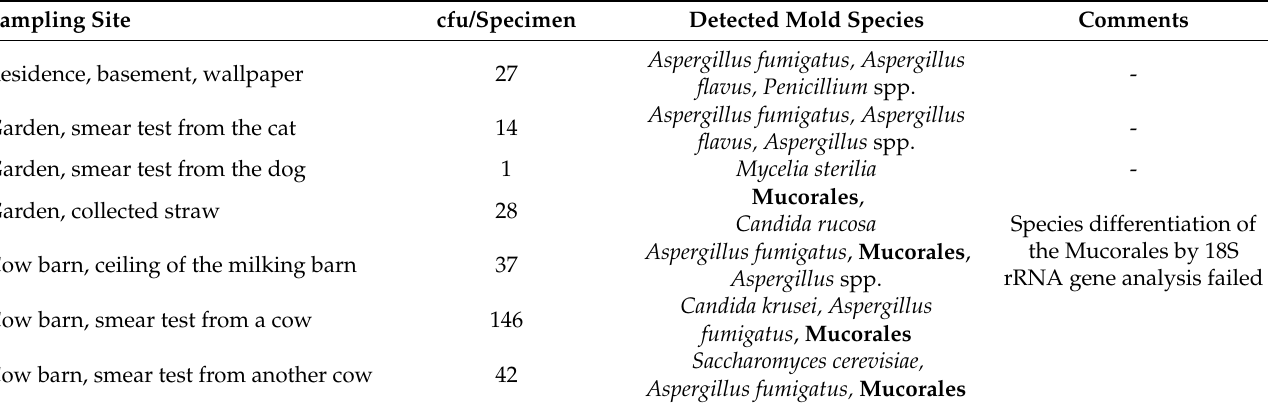
Table 2. Mold detections from smear tests. Due to the nasal colonization of the index patient, Mucorales are indicated in bold